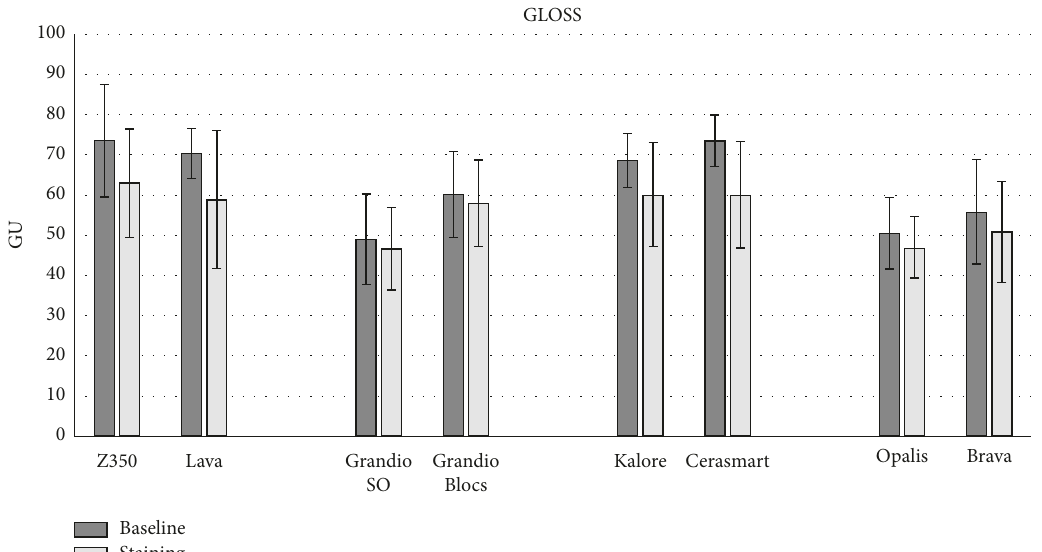
Figure 1: Means (SD) of gloss (GU) for all groups before and after